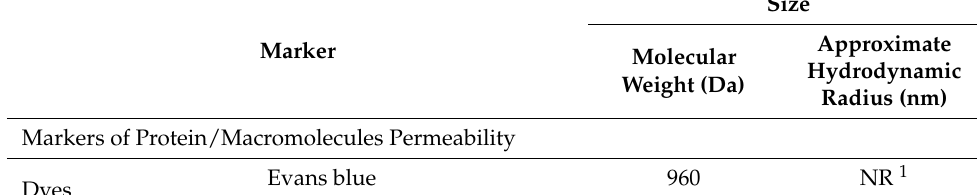
Table 4. Exogenous tracers categorized based on target solute/compound